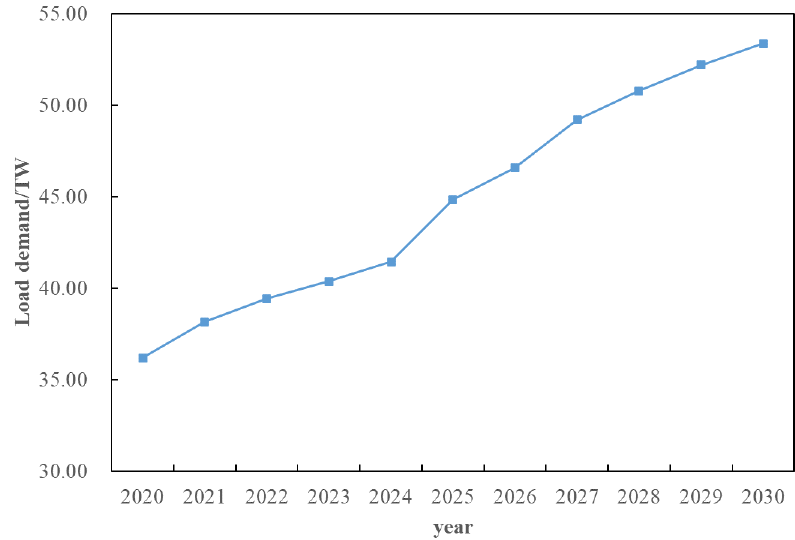
Figure 18. Load growth trend from 2020 to 2030.